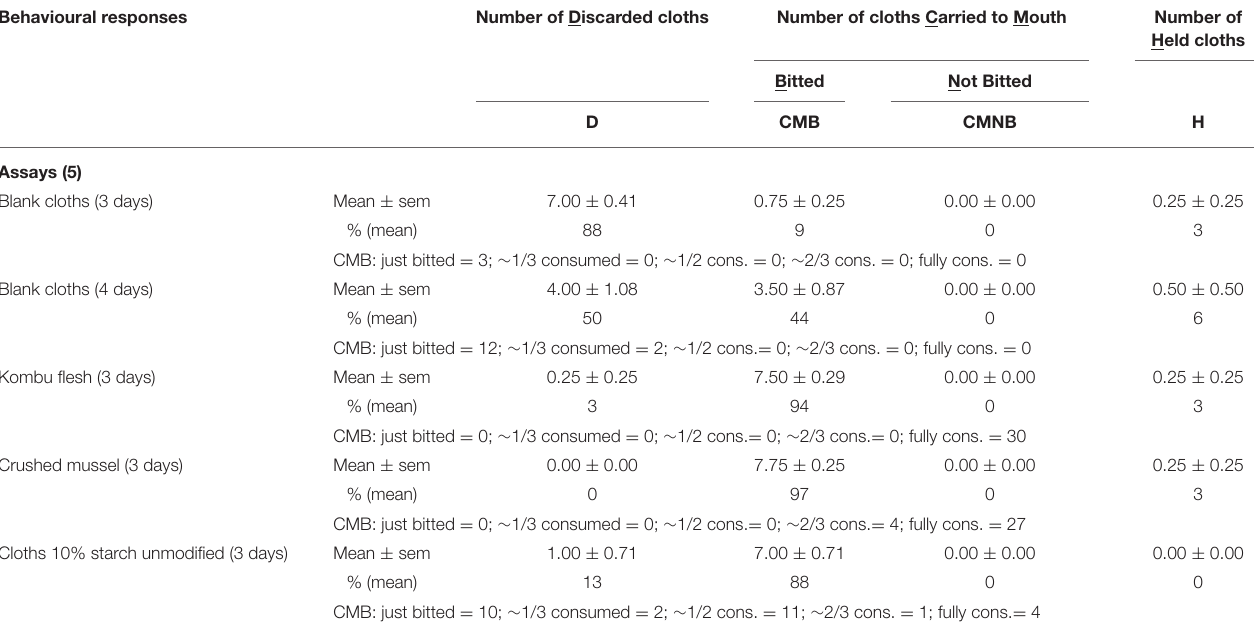
TABLE 2 | Longer duration tests with cotton-based (85%)